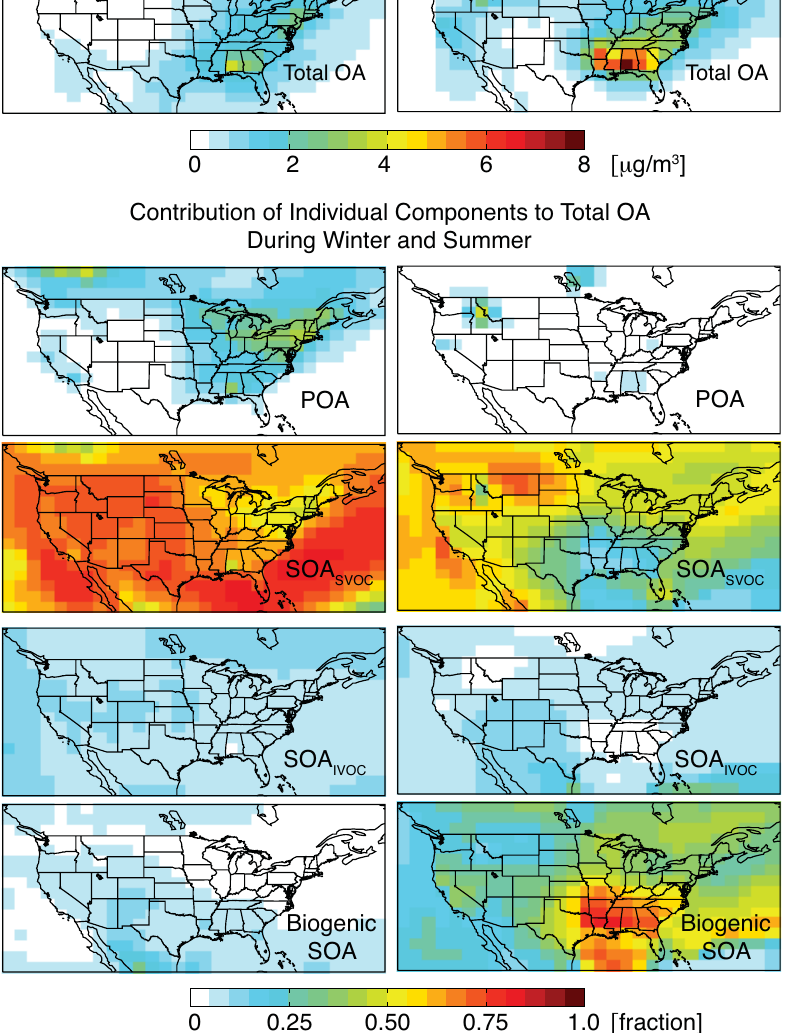
Fig. 6. Total OA and contribution of each component to winter and summer concentrations over the US. Not shown is the contribution of aromatic SOA to total OA. Fraction is fraction of total OA. Simulations are 2 ◦ × 2 . 5 ◦ with GEOS-4